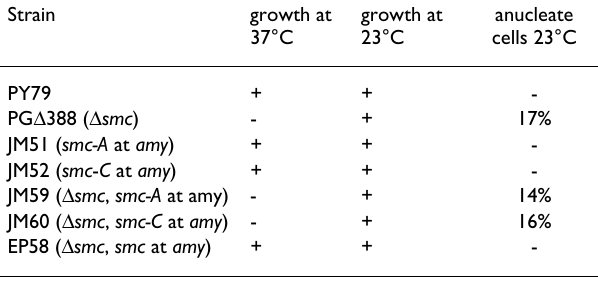
Table 2: growth of different strains Strain growth at